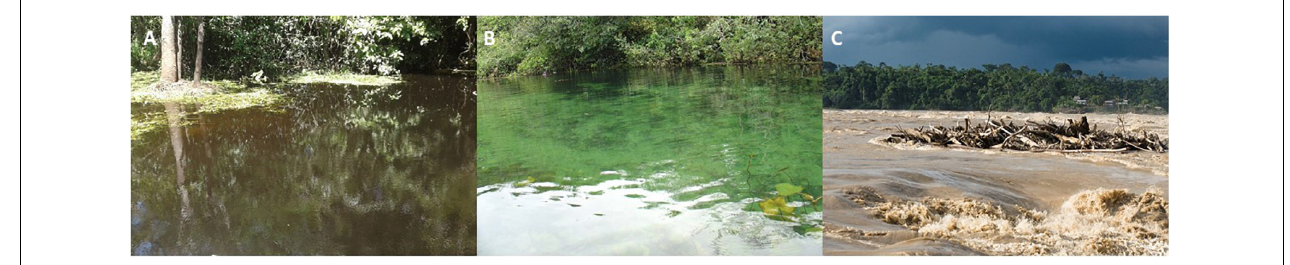
FIGURE 1 | Amazon water types. (A) Black, (B) clear, and (C) white water types. Photo credits: A—Elio Borghezan; B—Jansen Zuanon; C—Tiago Pires.